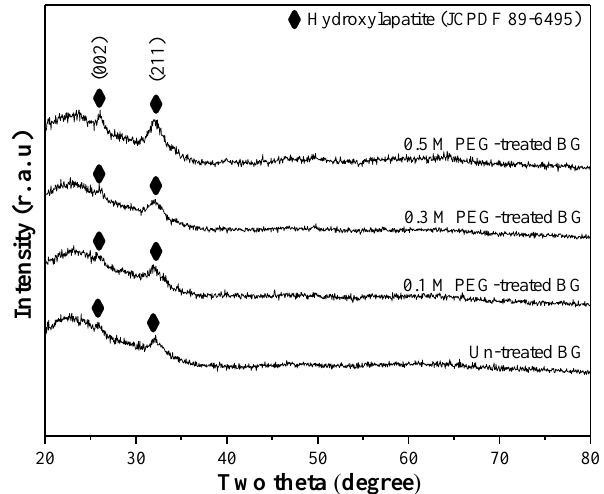
Figure 6. XRD patterns of un-treated BG powder and 0.1 M, 0.3 M, and 0.5 M PEG-treated BG powders after being immersed in SBF for one day.